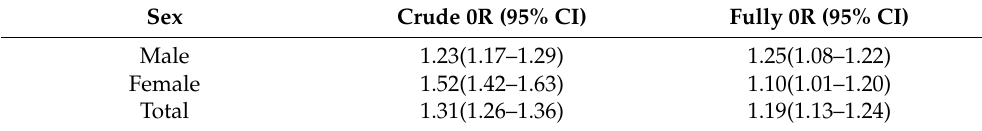
Table 2. Odds ratios of 100 µ mol/L higher SUA concentration for hypertension on a continuous scale.